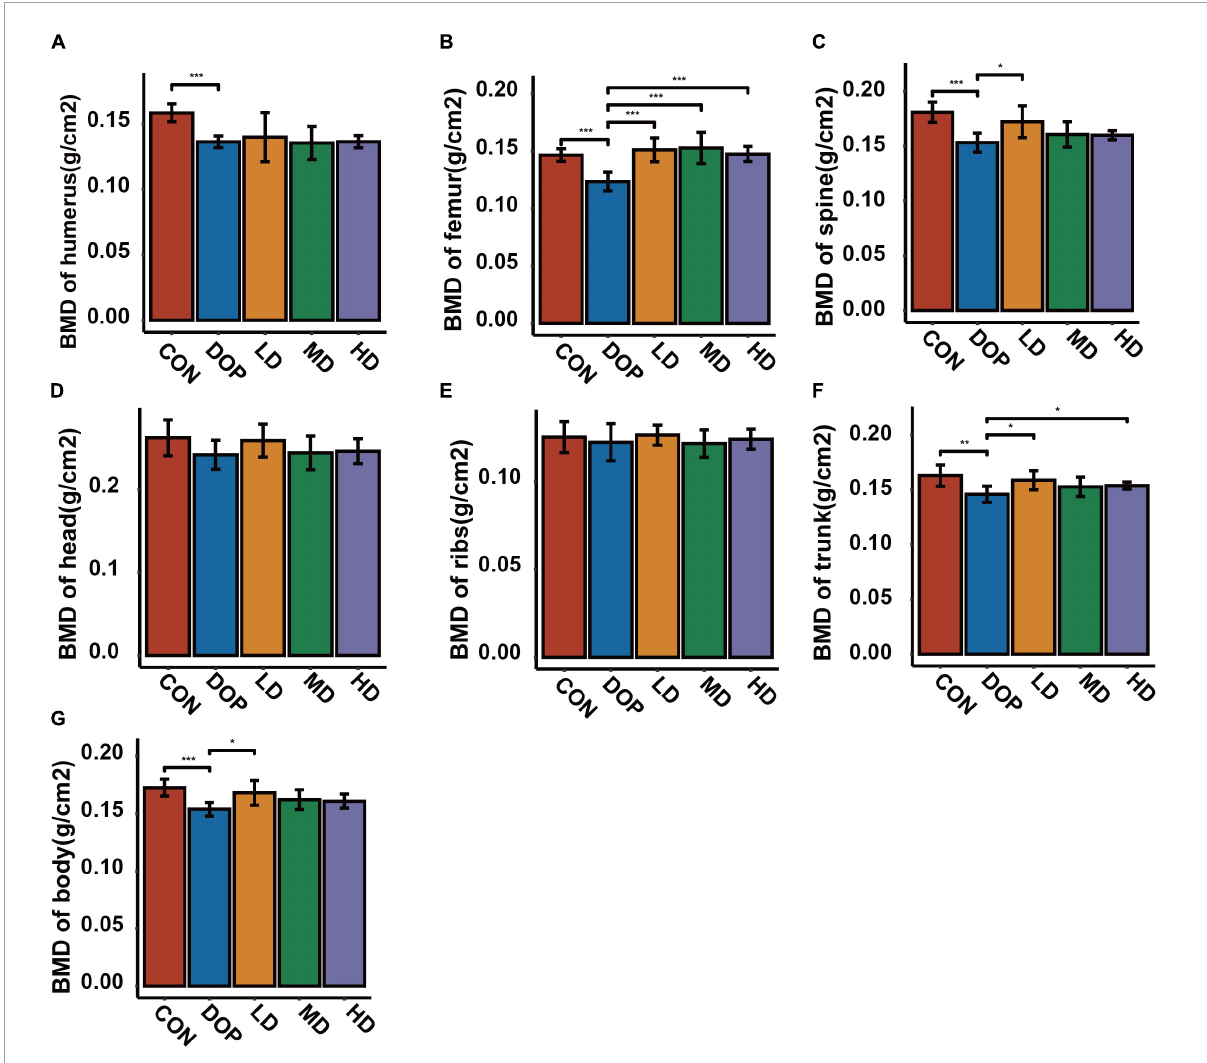
FIGURE2 Effects of S-Equol on bone mineral density (BMD) in different groups of rats after 12 weeks of gastric gavage. (A) BMD of the humerus; (B) BMD of the femurs; (C) BMD of the spine; (D) BMD of the head; (E) BMD of the ribs; (F) BMD of the trunk; (G) BMD of the body. All data are expressed as mean ± SD ( n = 5 for various parts of BMD). * p < 0.05, ** p < 0.01, *** p < 0.001 as compared to the diabetic osteoporosis (DOP)